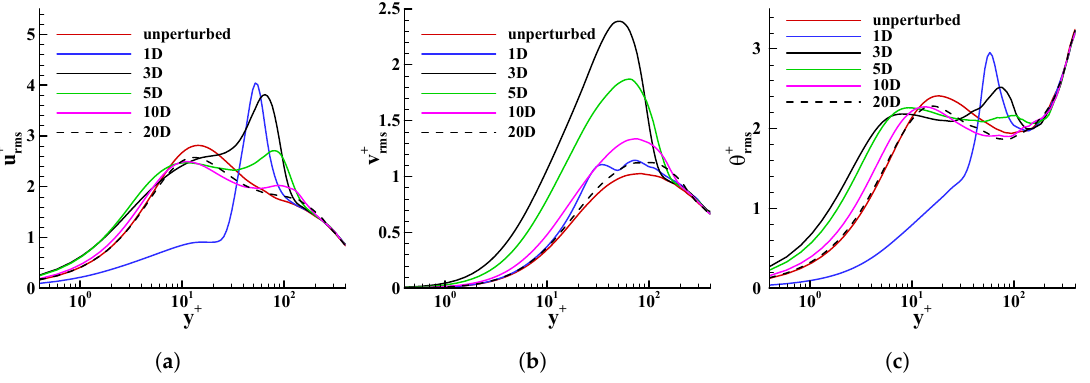
Figure 3. Variation of ( a ) streamwise velocity fluctuations; ( b ) wall normal velocity fluctuations; and ( c ) temperature fluctuations downstream, behind the